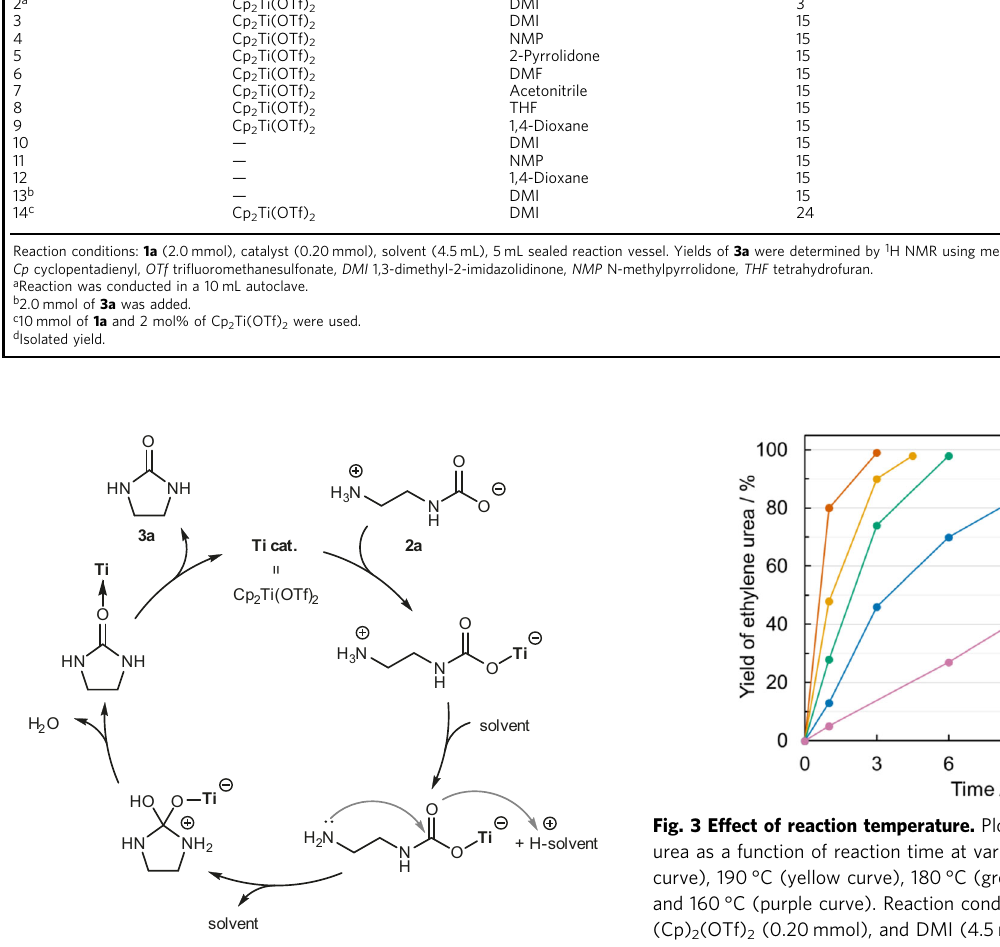
Fig. 2 Reaction mechanism. Plausible reaction mechanism for the Cp 2 Ti (OTf) 2 -catalyzed synthesis of ethylene urea 3a from alkyl ammonium carbamates 2a .